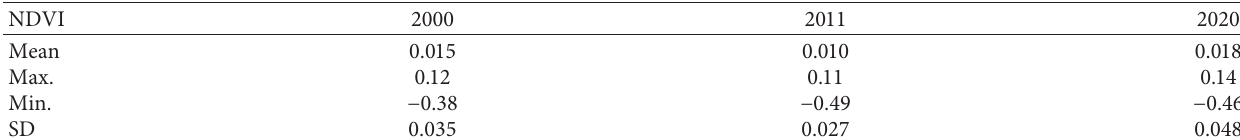
Table 3: Year-wise NDVI values statistics